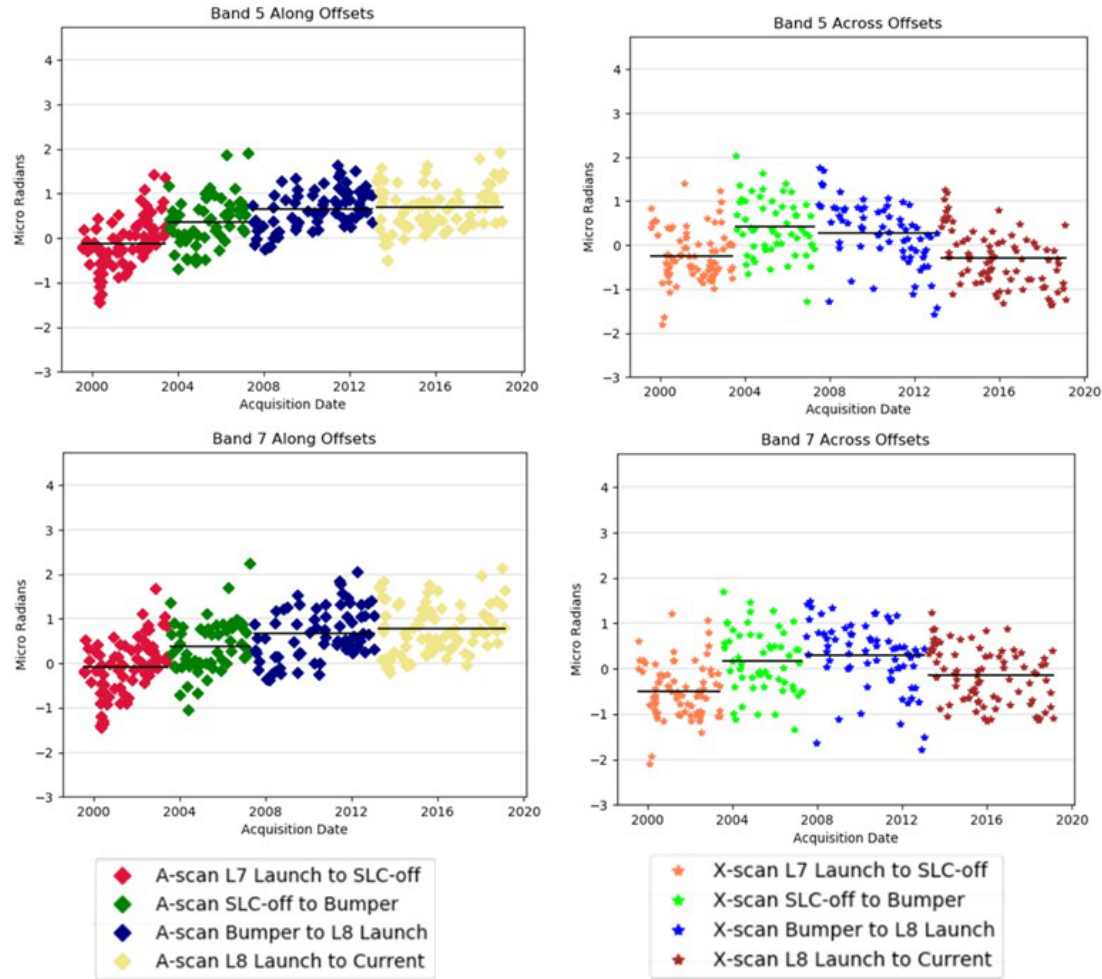
Figure 10. Band focal plane measurements for Collection 2 data are shown. Values are color-coded to represent time frames, which were broken out for calibration. The values displayed are after focal plane calibration. The offsets that were present in Figure 9 have been reduced. A-scan refers to the along scan direction of the instrument, while X-scan refers to the across- scan direction of the instrument.